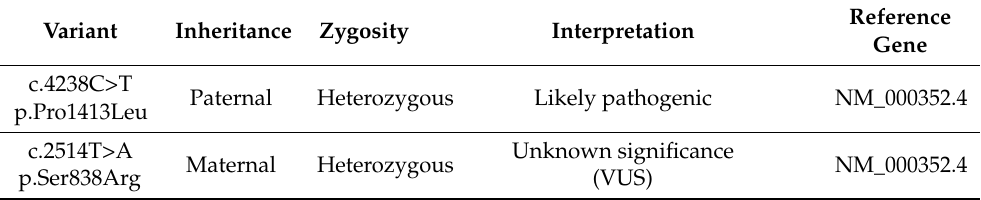
Table 1. Results of genetic analysis ( ABCC8